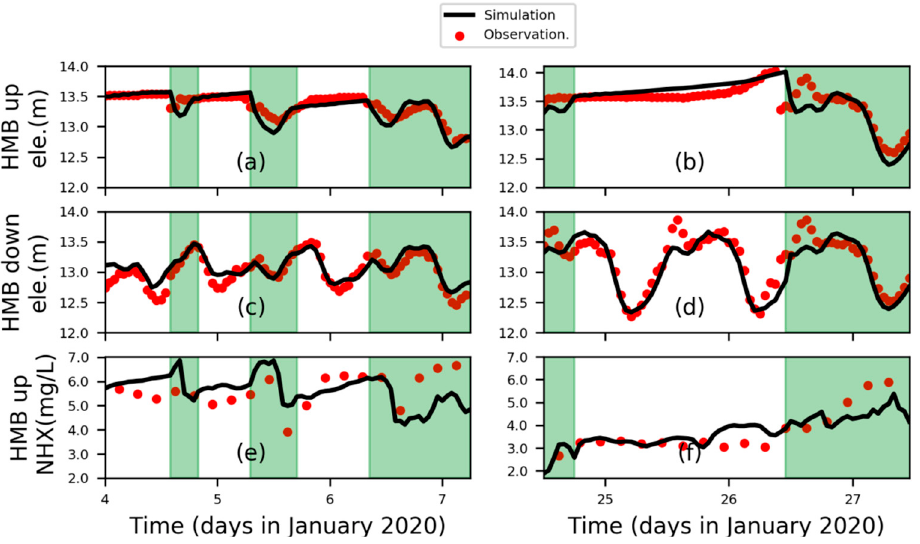
Table 1. Statistical summary of the difference between observation and results of the simulation, using correlation coefficient (r) and model skills (SS).